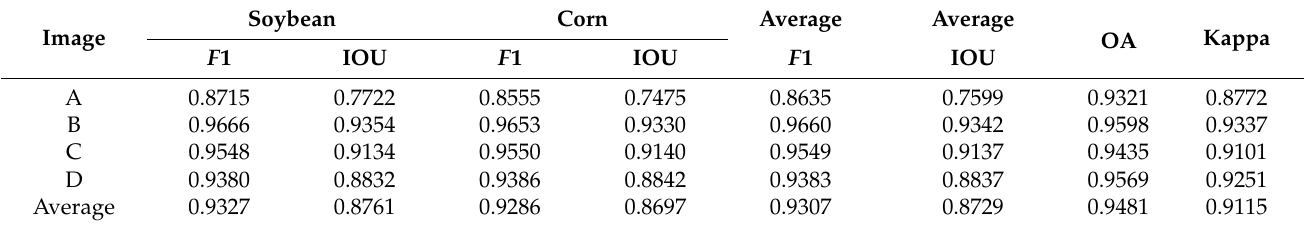
Table 1. The classification accuracy of crop classification, based on the MACN.